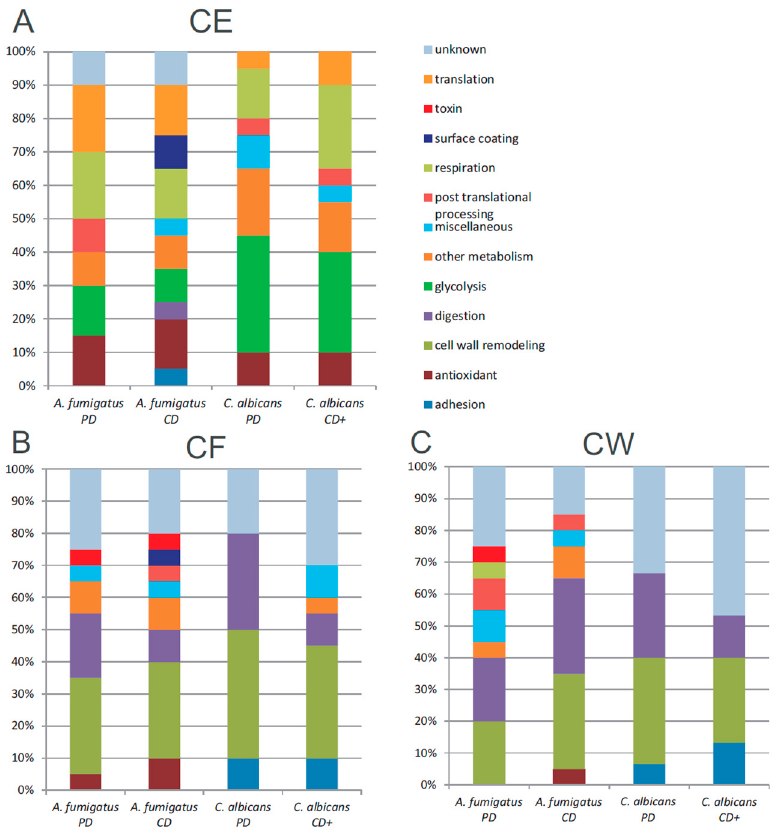
Figure 5. Functional annotation of the most abundant proteins in A. fumigatus and C. albicans . PD—Potato Dextrose Medium. CD—Czapek Dox Medium (+—with casamino acid